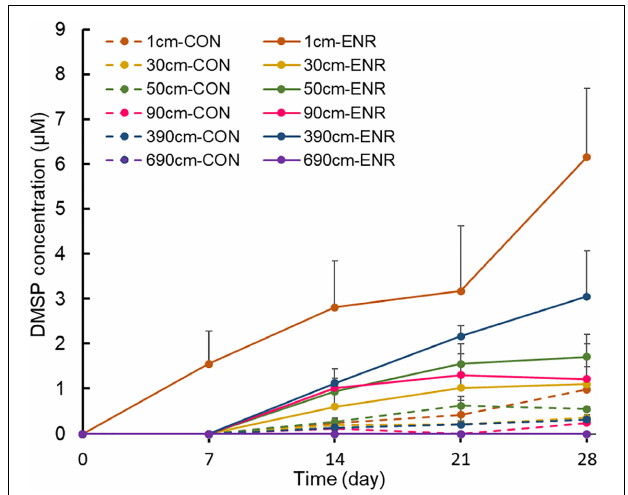
FIGURE 2 | Changes of DMSP concentrations during the enrichment incubation for DMSP production. “0” means that DMSP concentration